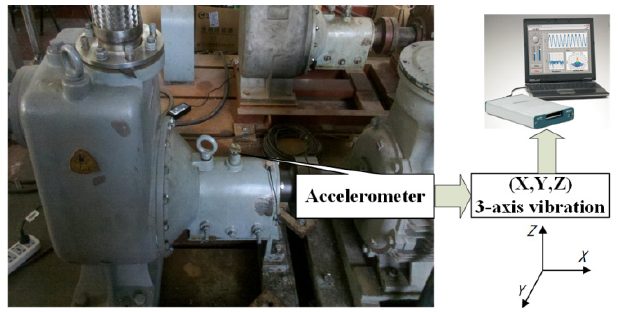
Figure 5. Data acquisition system of the centrifugal pump.